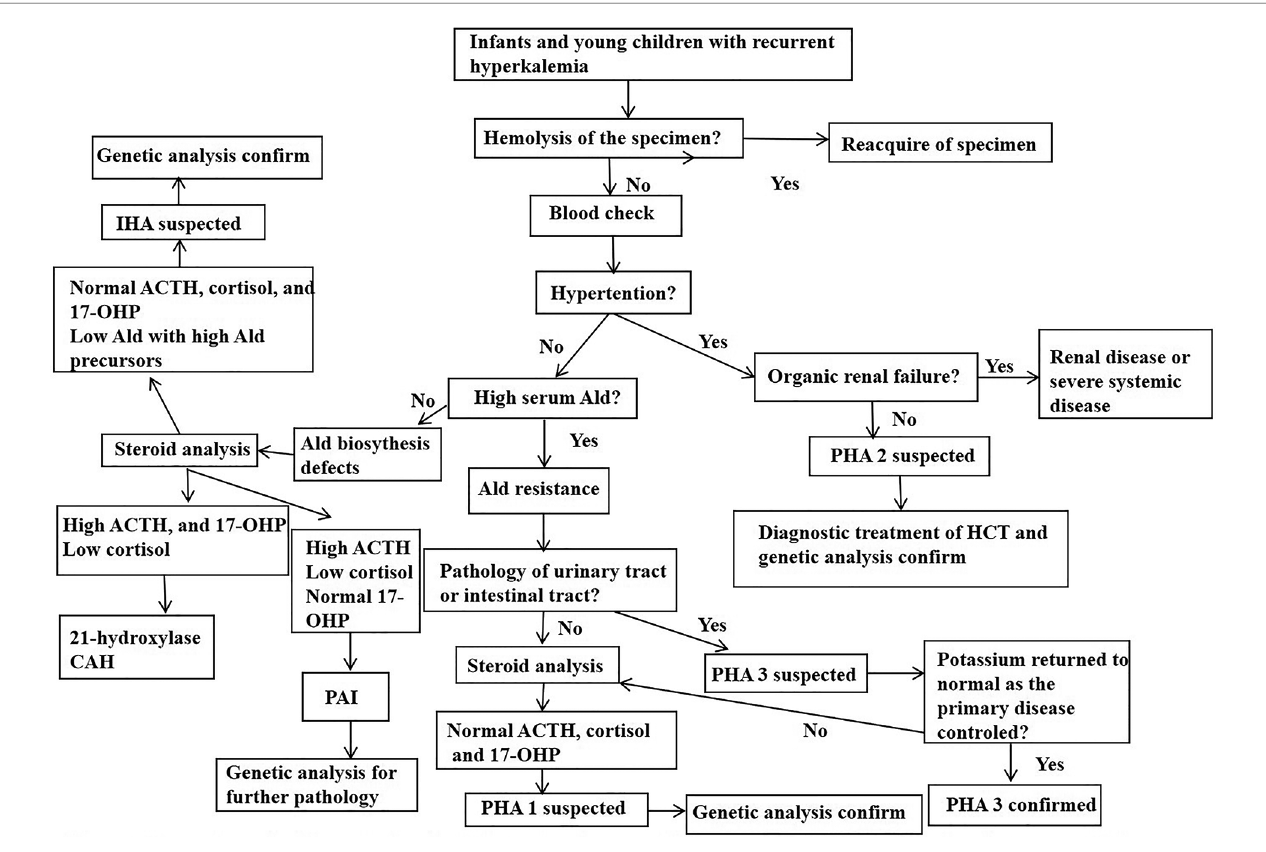
FIGURE 1 Proposed diagnostic procedure for inants and young children presenting with hyperkalemia who is suspected of aldosterone signal defect. Ald, aldoterone; CAH, congenital adrenal hyperplasia; PHA, pseudohypoaldosteronism; IHA, isolated hypoaldosterone; HCT, hydrochlorothiazide; 17-OHP, 17-